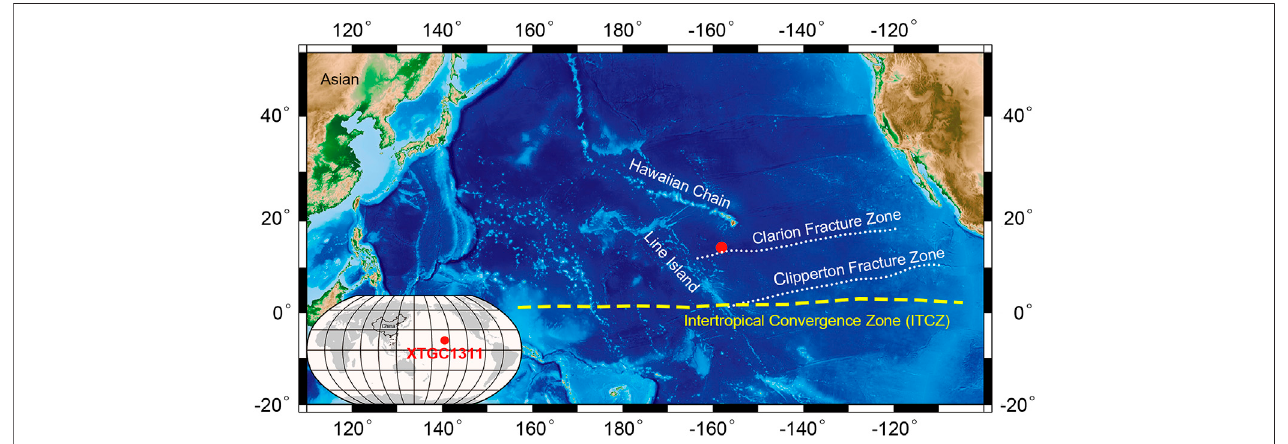
FIGURE 1 | Location map with the position of sample